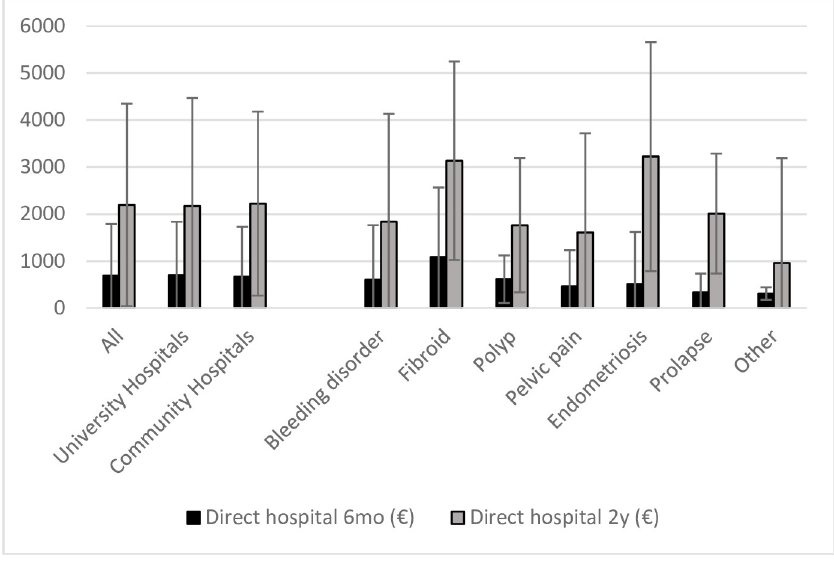
Fig 1. Direct mean hospital costs ( € ) according to hospital and diagnosis group (standard deviation represented by deviation lines).